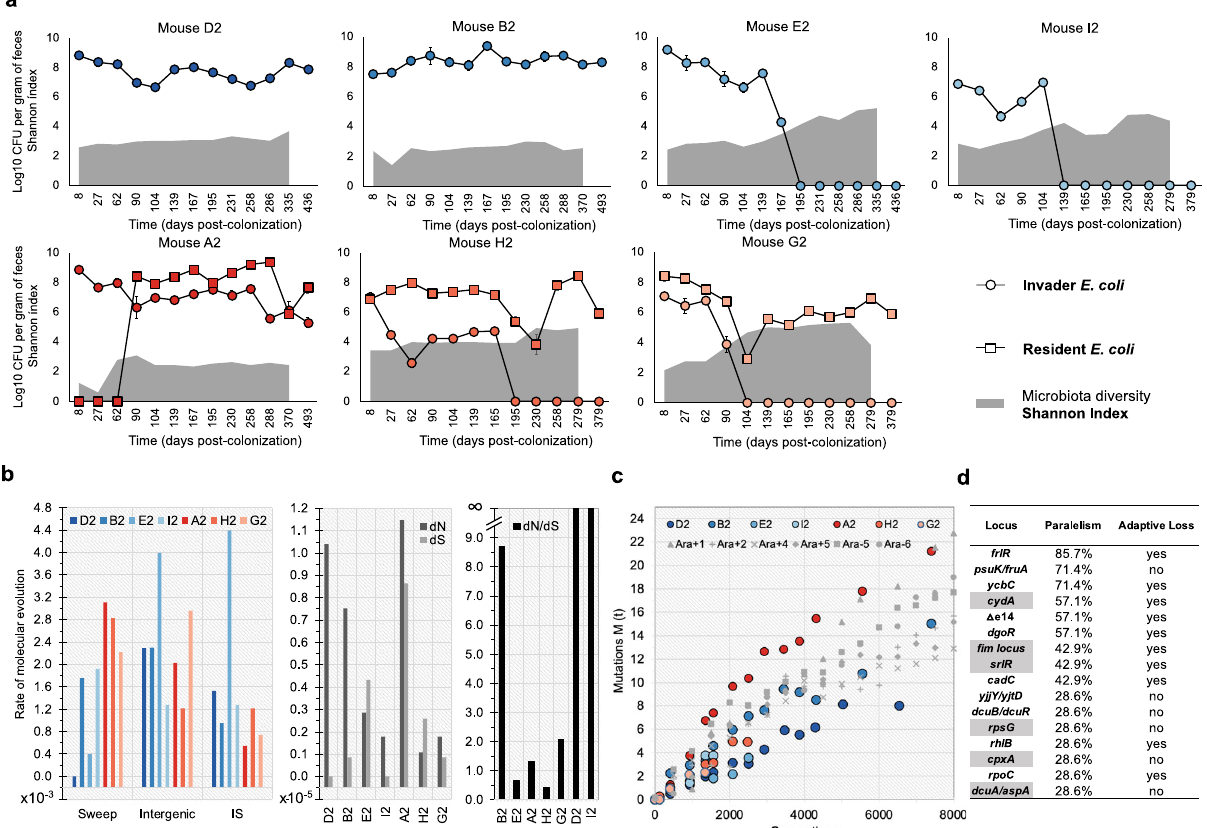
Fig. 1 | Colonization success depends on microbiota diversity and rates of molecular evolution across mice.a Time series of the abundances of the invader (circles) and resident (squares) E. coli lineages. Each circle represents the mean value and error bars represent 2*Standard Error (2SE) ( n =3 technical replicates, Supplementary Data 1). Time series of the microbiota species diversity (Shannon diversity). The values of microbiota diversity observed are shown as a gray area. b Rate of molecular evolution, per generation, in each host (sweeps, intergenic mutations, Insertion Sequences). dN and dS, and dN/dS ratio. c E. coli mutation accumulation during in vivo and in vitro evolution (data of non-mutator lines